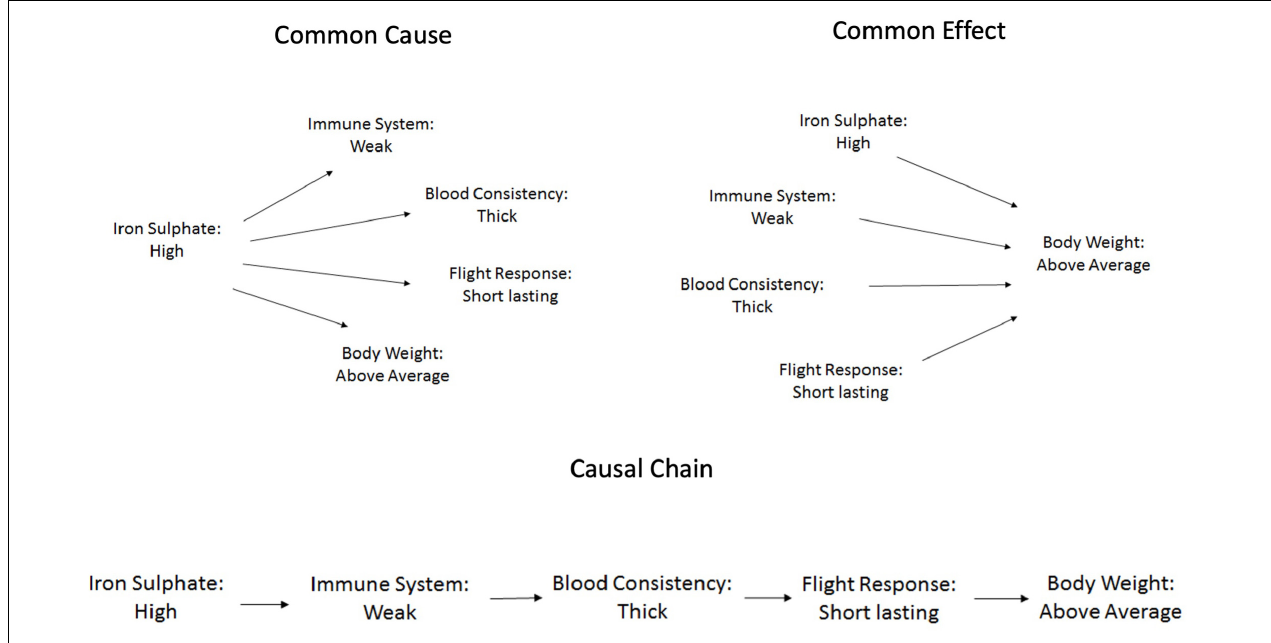
FIGURE 5 | Causal structures for the three causal conditions for Kehoe ants (Studies 4 and